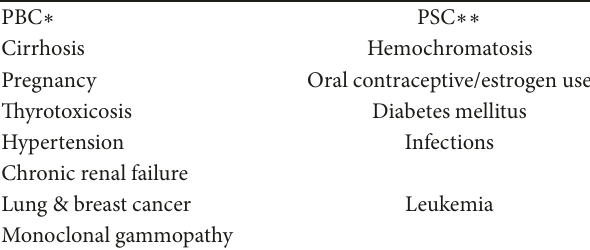
Table 2: Differential diagnosis of